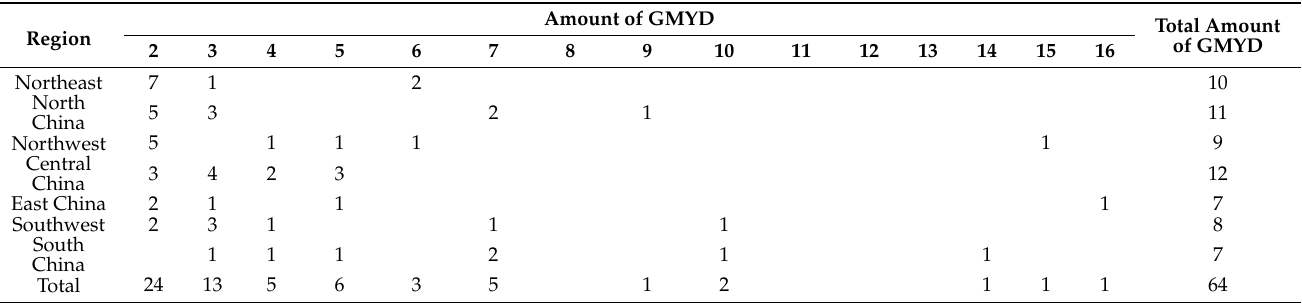
Table 1. Statistics of GMYDs in all seven regions of China from 1961 to 2021.